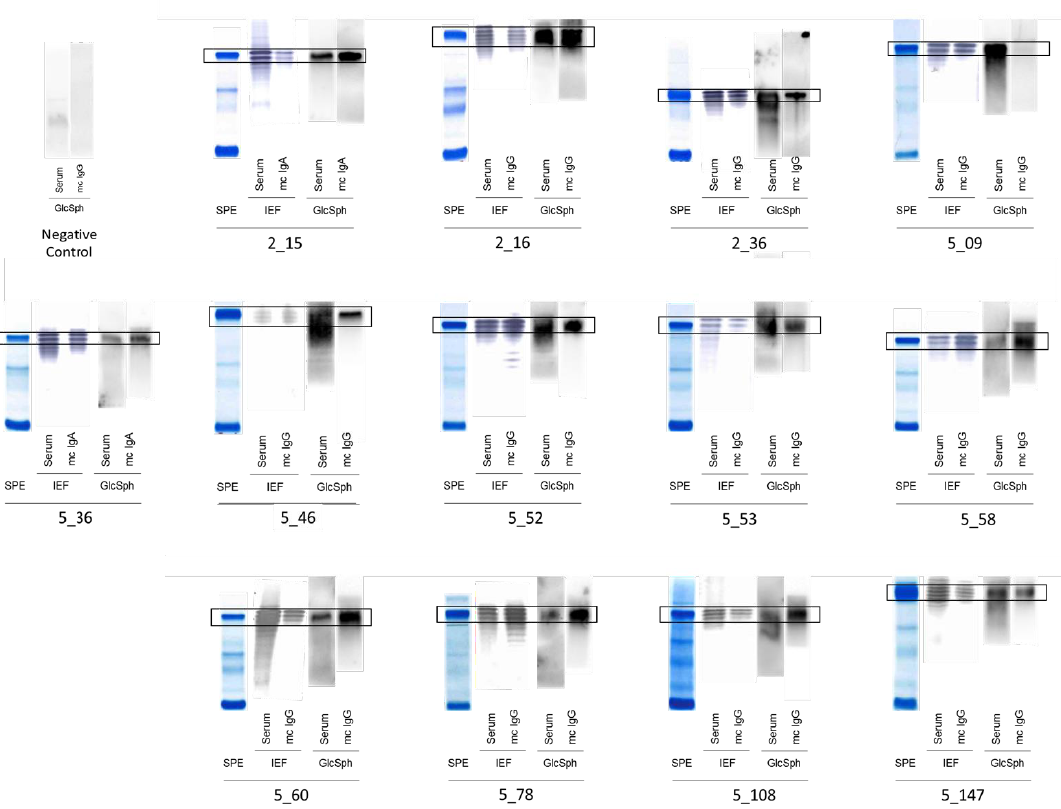
Figure 2. GlcSph-reactivity of serum Igs and monoclonal Igs in MM. Measurement of Ig concentration, separation of monoclonal Igs from other Igs, and verification of purity are performed as described above (Figure 1), in Methods, and published previously [5–7,14,15]. SPE = Serum protein electrophoresis; Mc Ig = purified monoclonal Ig. Signals corresponding to the patient’s monoclonal Ig are encircled. The negative control is a patient with no GlcSph-reactive Ig in serum.